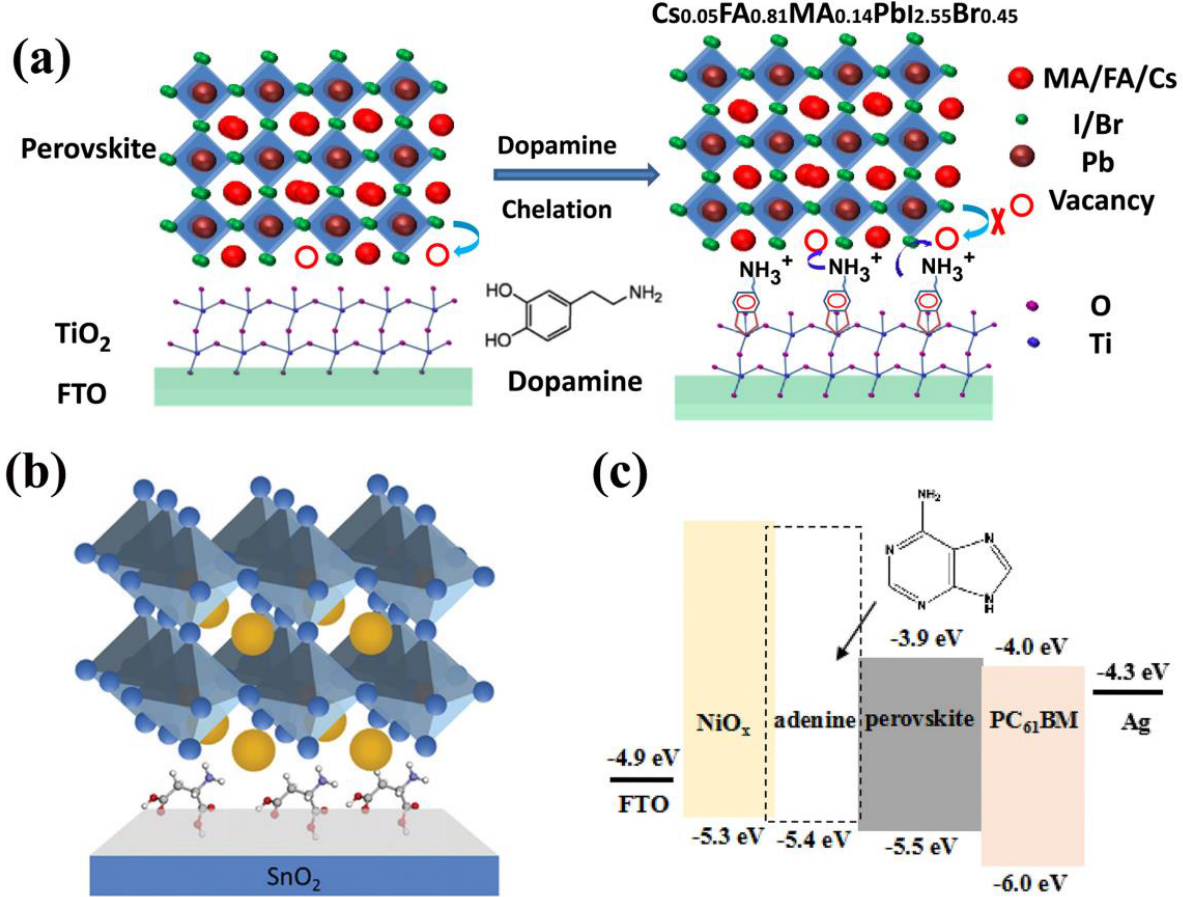
Figure 2. Instances of natural molecule-based interface engineering for PSCs: ( a ) Schematic diagram of dopamine function between the perovskite and TiO 2 interface [38]. Copyright 2019,